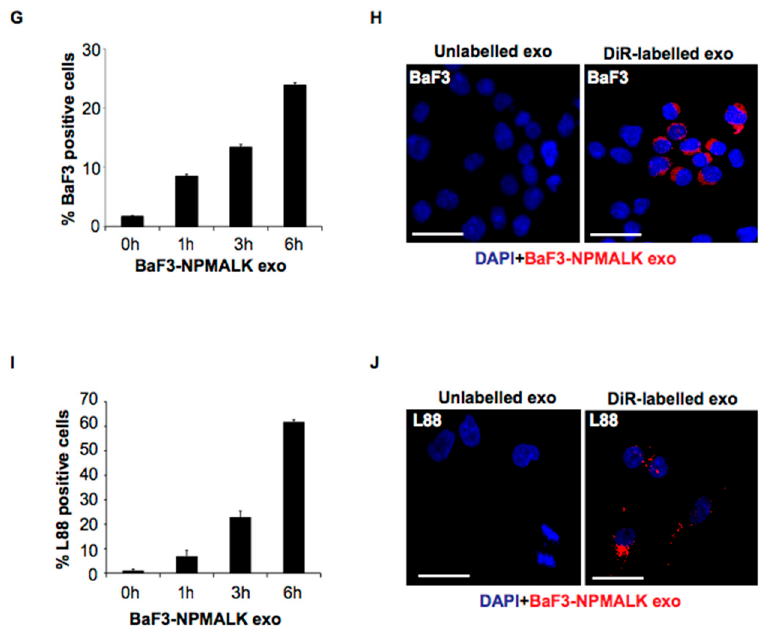
Figure 2. ALK+ ALCL-derived exosomes are taken up by Ba/F3 cells with apparent biologic ef- fects: ( A , B ) DiR-labelled SUP-M2 secreted exosomes (20 µ g/mL) were added to the Ba/F3 cells for the time points as indicated and the uptake was quantified by flow cytometry and depicted by confocal microscopy. After 6 h, the exosome uptake reached a level of approximately 75% as shown ( B ); ( C ) Immunoblots showing detection of CD30 and the anti-apoptotic protein cFLIP in Ba/F3 cells following uptake of exosomes derived from two ALK+ ALCL cell lines, Karpas 299 and SUPM2; ( D ) Proliferation of Ba/F3-cells with or without IL-3 (10 ng/mL) and 30 µ g SUP-M2-exosomes. 10 4 Ba/F3-cells in a volume of 100 µ L were cultured in the settings as shown for 48 h. To determine the proliferation of the cells, 20 µ L CellTiter-Blue ® Reagent (Promega, Madison, WI, USA) was added and the fluorescence at 560/590 nm was determined at the indicated timepoints. The highest level of proliferation fraction in the cells treated with 30 µ g SUP-M2 exosomes (no IL-3) was observed at 8 h and exceeded that of IL-3 treated cells (* p < 0.05, ** p < 0.01); ( E ) Nanoparticle